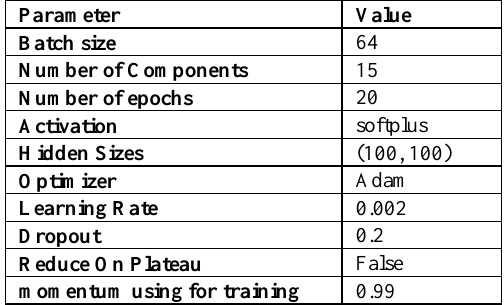
Table 1 . Settings of the implemented